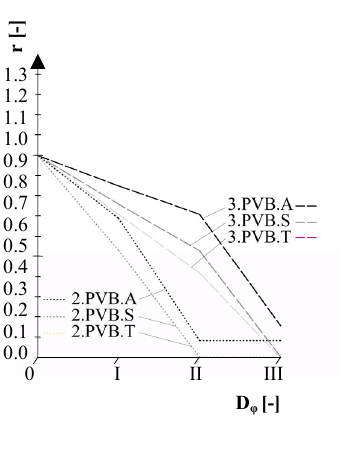
Figure 18: Relative redundancy curves for SG laminated glass